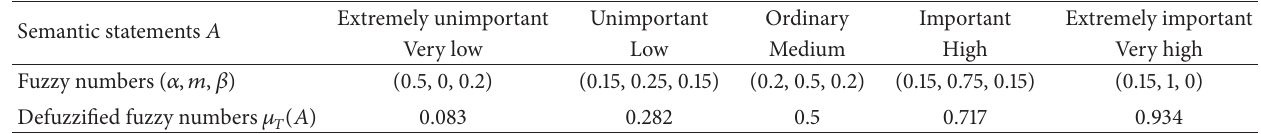
Table 6: Semantically statements conversion table.